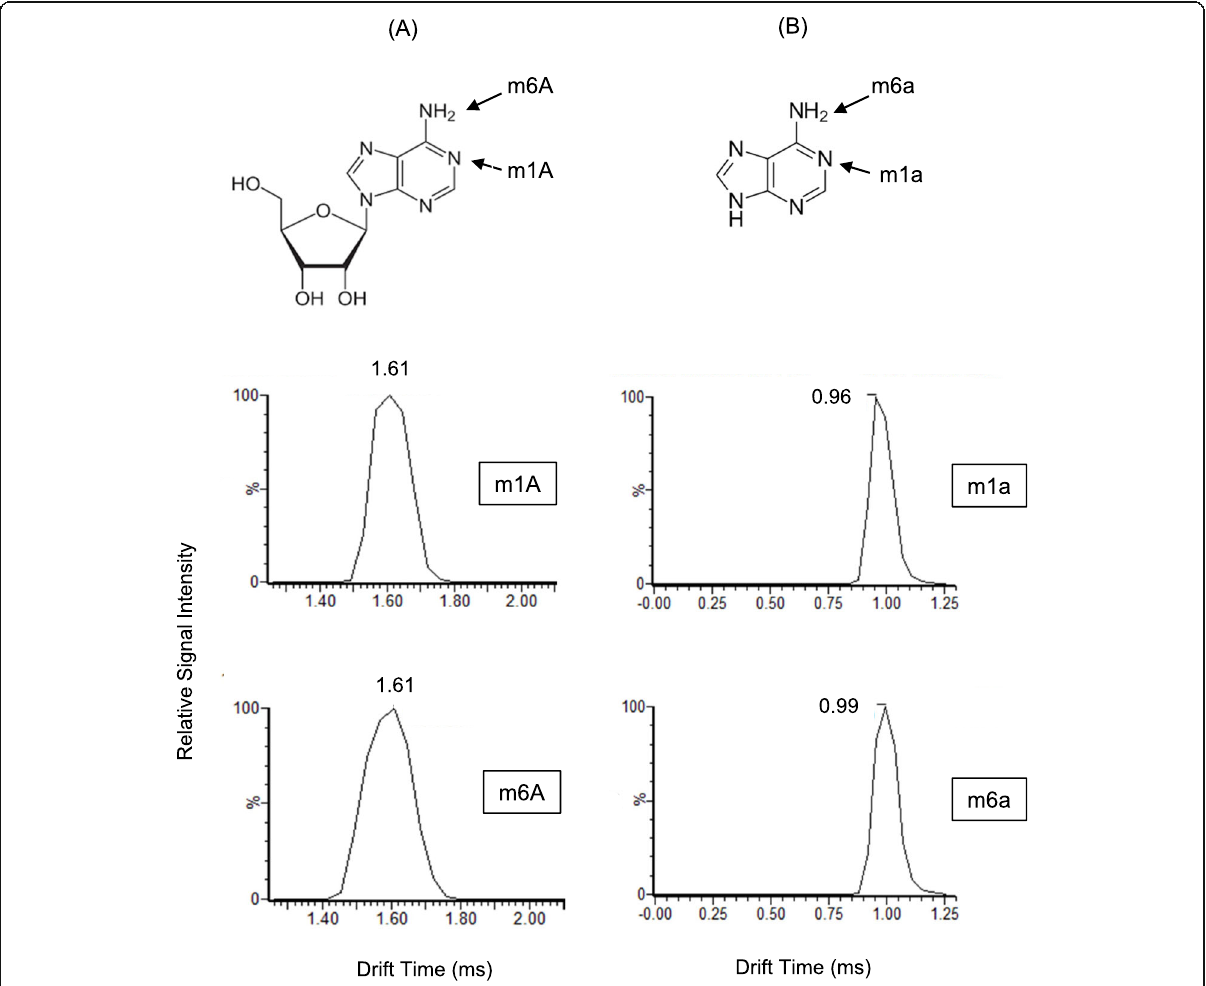
Fig. 2 a Molecular structure of m1A and m6A, and their corresponding extracted ion mobility spectra which were acquired by using the standard IM method. b Molecular structure of m1a and m6a, and their corresponding extracted ion mobility spectra which were acquired by using the SRI method. A, adenosine; a,